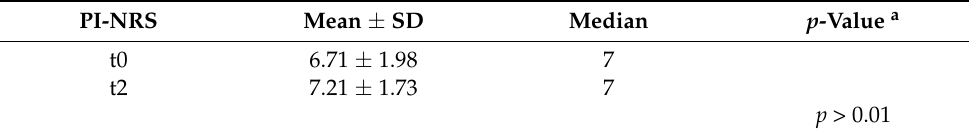
Table 2. Mean and Median of Group Control (44 subjects) at t0 and t2 (8